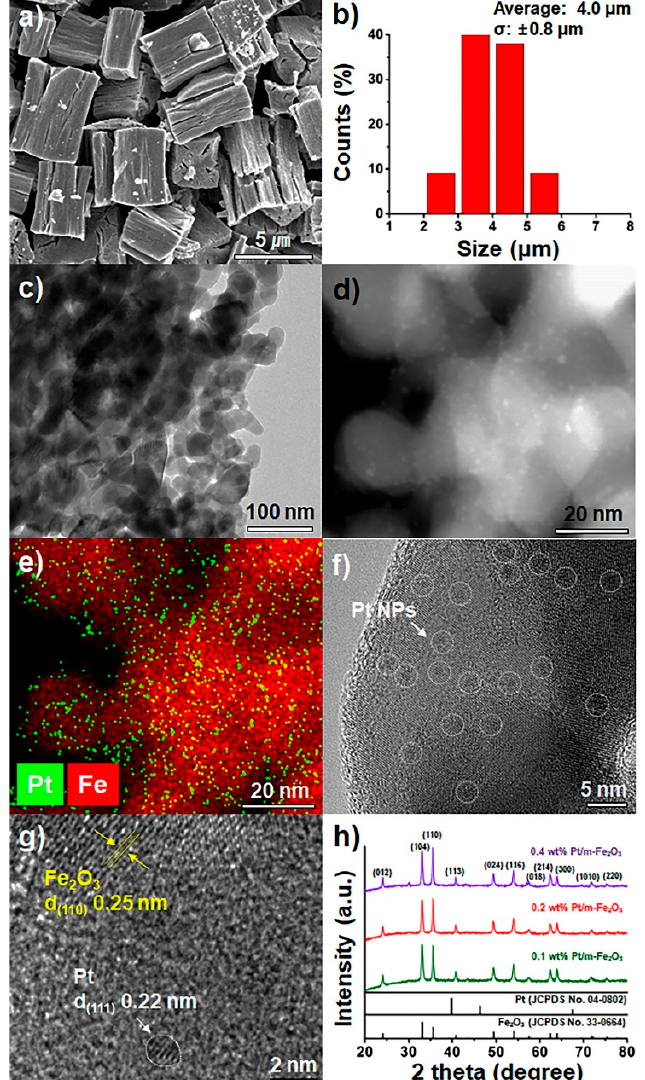
Figure 1. ( a ) SEM image; ( b ) particle size distribution histogram; ( c ) TEM image; ( d ) HAADF-STEM image; ( e ) elemental mapping image; ( f ) magnified TEM image; ( g ) HR-TEM image of 0.2 wt% Pt/m-Fe 2 O 3 ; and ( h ) XRD spectra of the Pt/m-Fe 2 O 3 samples. The X-ray diffraction (XRD) patterns in all Pt/m-Fe 2 O 3 samples with the different Pt contents identically represent peaks at 2 θ = 24, 33, and 36 ◦ , assigned to the reflections of the (012), (104), and (110) planes of a Fe 2 O 3 rhombohedral structure (Figure 1h, JCPDS No. 33-0664). In the XRD spectra, no significant difference was observed between Pt/m-Fe 2 O 3 and Pt-free m-Fe 2 O 3 (Figure S1d). Using the Debye–Scherrer equation based on the peak broadening of the (110) reflection in the Pt-doped samples, the Fe 2 O 3 crystal domain sizes were measured to be around 35 nm, which matched well with the size observed in the TEM images. The N 2 sorption experiment at − 196 ◦ C for the Pt/m-Fe 2 O 3 exhibited type IV adsorption–desorption hysteresis (Figure 2a). The Brunauer–Emmett–Teller (BET) surface area and total pore volume were calculated to be 25 m 2 · g − 1 and 0.13 cm 3 · g − 1 ,